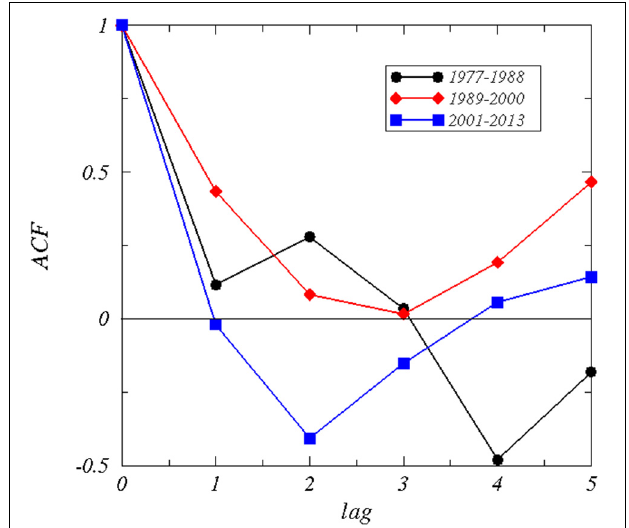
FIGURE 3 | Autocorrelation function of winter NAO for different periods.